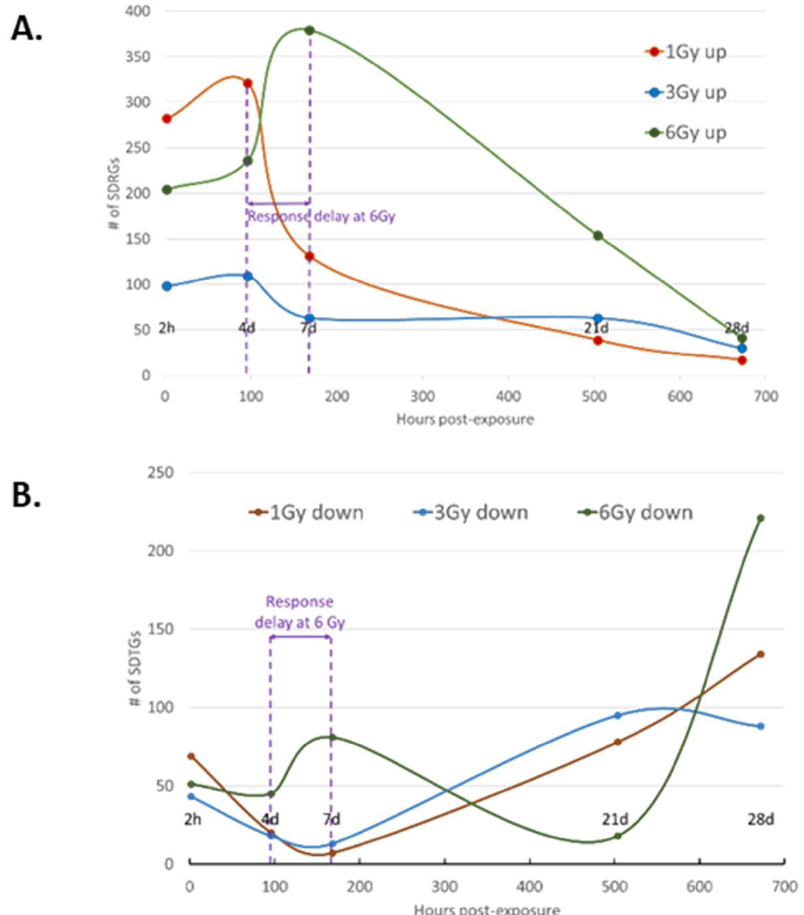
Figure 6. Regulation pattern variation in SDTGs in skin biopsies of mice exposed to sublethal doses (1, 3, and 6 Gy) of X-ray radiation during the study time course. Patterns in upregulated SDTGs ( A ) and downregulated SDTGs ( B ). Note the peak in upregulation and troughs in downregulation coincided at 1 and 3 Gy doses, while downregulation at 6 Gy seemed to have more than one phase.